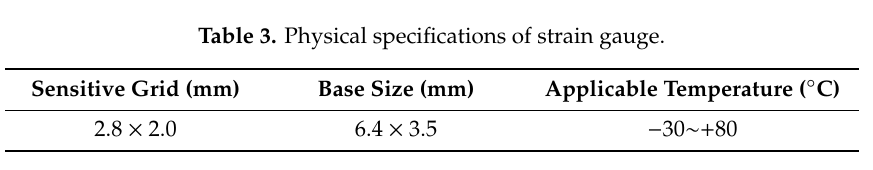
( b ) Figure 1. Soil sample: ( a ) fine sand; ( b ) result of heavy compaction test.